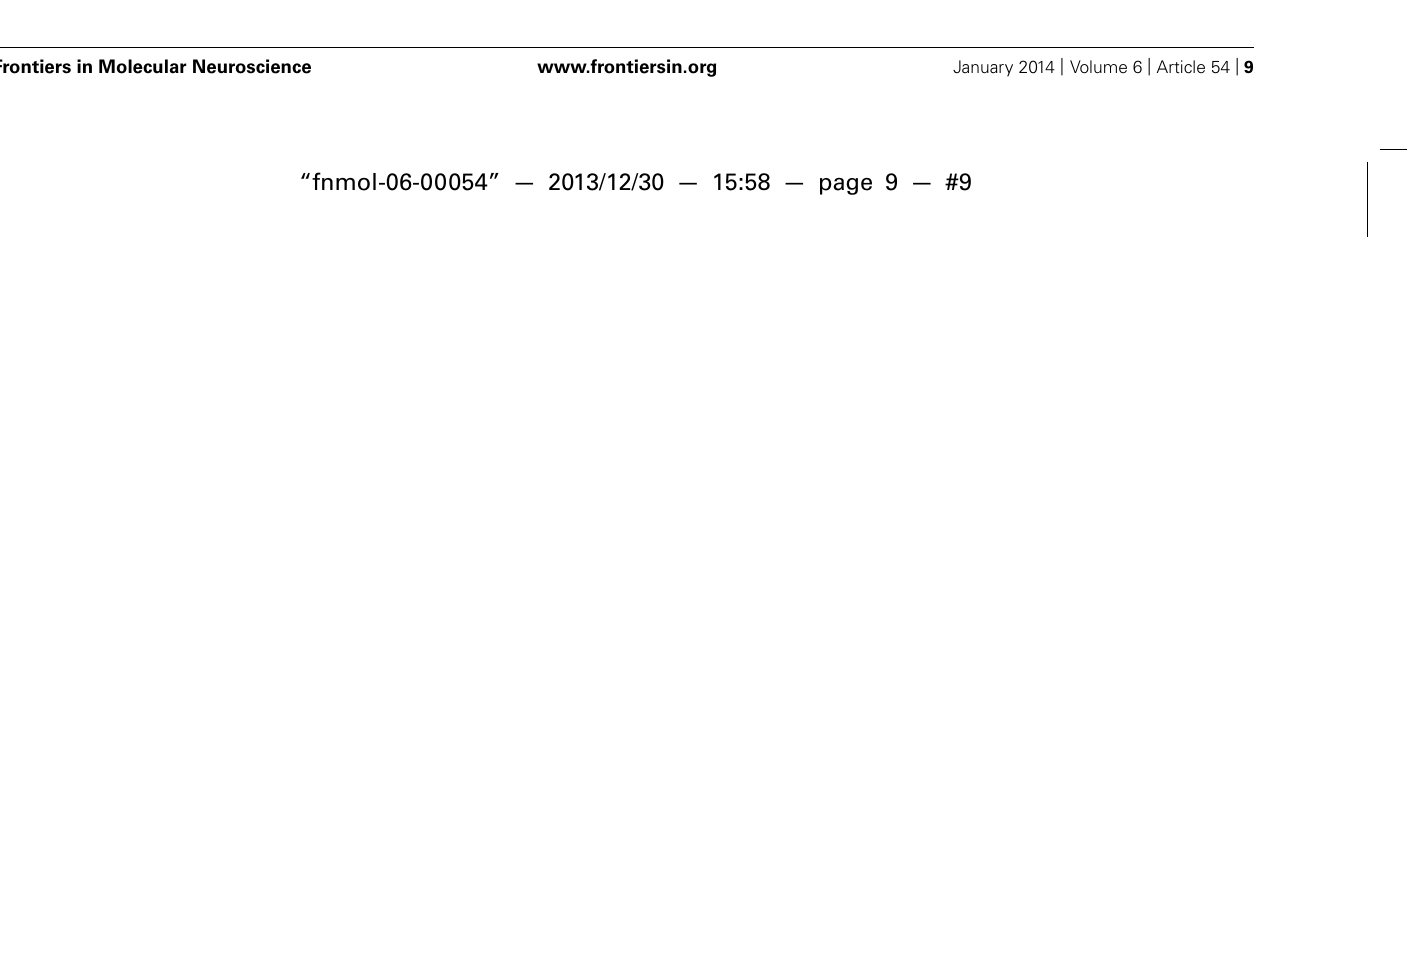
FIGURE 4 | In vivo transient increment of ongoing activity in synaptic inputs to CA1. (A) Hippocampal raw LFPs recorded in depth profiles by linear probes (rec in left scheme). Only every other site is represented.The ICA analysis of linear raw LFPs rendered two main LFP generators in the CA1 region, one centered in the striatum radiatum or Schaffer-LFP generator (blue) and other in the striatum lacunosum-moleculare (lac/mol generator; in red). Each had a characteristic spatial distribution (see normalized relative spatial weight in vertical plots), while the temporal activation was specific to the epoch analyzed (color traces to the right).The baseline activity of the Schaffer LFP generator consists of a regular succession of small field potential wavelets at gamma frequency termed μ -fEPSPs [enlargement in (B) ]. (C,D)